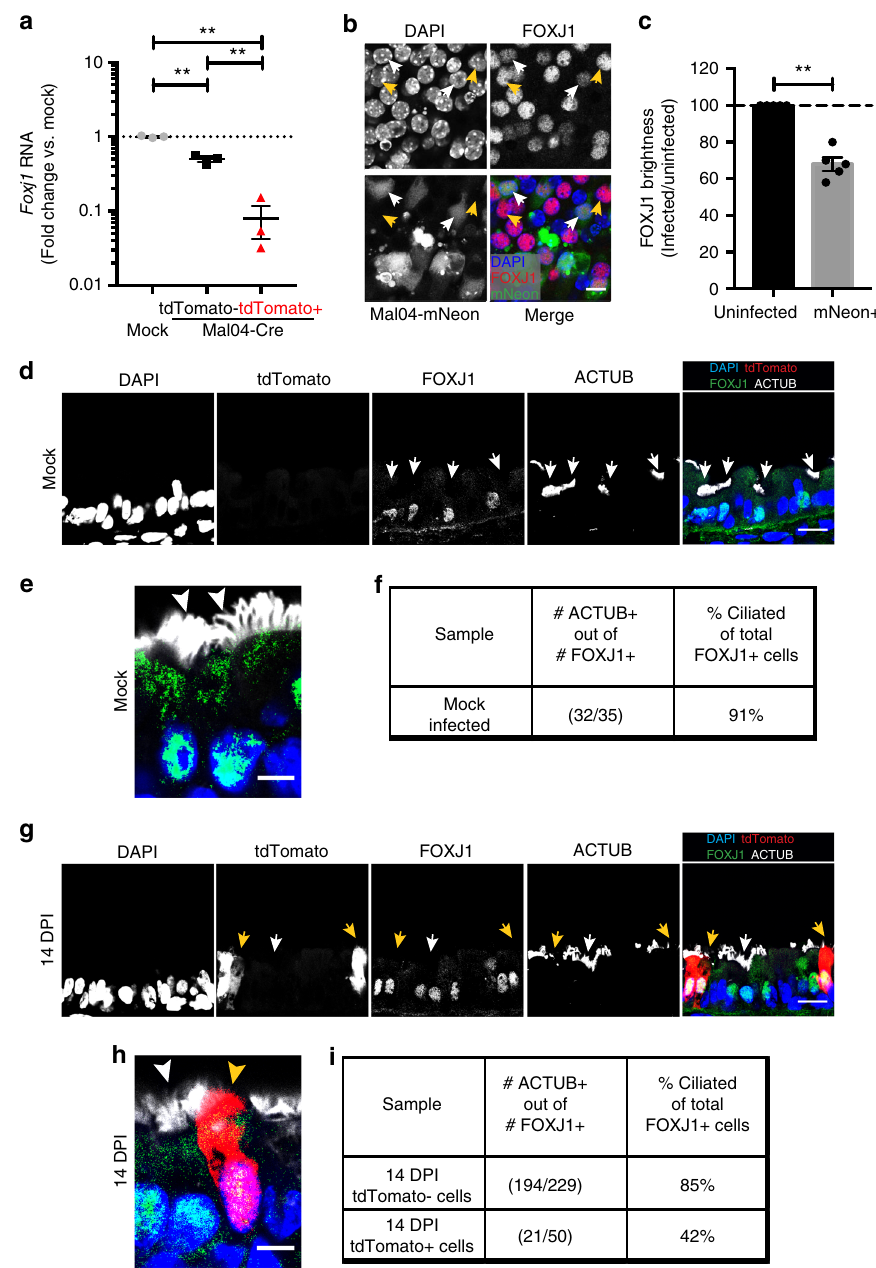
Fig. 5 Ciliated-like survivor cells display reduced expression of ciliated cell transcription factors and fail to elaborate surface cilia. a Quantitative RT-PCR measuring RNA levels of Forkhead Box J1 (Foxj1) in fl ow sorted EpCam + CD24 + mock infected cells, tdTomato − (uninfected cells), and tdTomato + (survivor cells) at 14 days post-infection. n = 3 mice per sample, one-way ANOVA. b Air – liquid interface differentiated cultures of primary murine epithelial cells were infected with Mal/04-mNeon (green) and stained for FOXJ1 (red). White arrows = mNeon + (infected cells), yellow arrows = mNeon − (uninfected cells). c Quanti fi cation of FOXJ1 brightness per cell, normalized to brightness of uninfected cells. n = 6 images, at least four cells quanti fi ed per image for each group, Student ’ s T -test. d Microscopy of cross-sectioned murine tracheas from mock infected mice where epithelial cells were stained for FOXJ1 and acetylated tubulin for mature cilia. White arrow = tdTomato − (uninfected cells) with intact cilia. e Close-up panel of uninfected murine tracheal ciliated cells stained for FOXJ1 and ACTUB. White arrow = tdTomato − (uninfected cells) with intact cilia. f Quanti fi cation of uninfected cells that are double positive for FOXJ1 and ACTUB. g Microscopy of cross-sectioned murine tracheas from Mal/04-Cre infected mice at 14 DPI where epithelial cells were stained for FOXJ1 and ACTUB. White arrow = tdTomato − (uninfected cells) with intact cilia, yellow arrows = tdTomato + (survivor cells) lacking surface cilia. h Close-up panel of murine tracheal uninfected Mal/04-Cre infected cells stained for FOXJ1 and ACTUB. White arrow = tdTomato − (uninfected cells) with intact cilia, yellow arrows = tdTomato + (survivor cells) lacking surface cilia. i Quanti fi cation of Mal/04-Cre infected cells: tdTomato − (uninfected cells) and tdTomato + (survivor cells) that are double-positive for FOXJ1 and ACTUB. S.E.M. was plotted to indicate variability around the mean for tested samples, * p ≤ 0.05, ** p ≤ 0.001, ns not signi fi